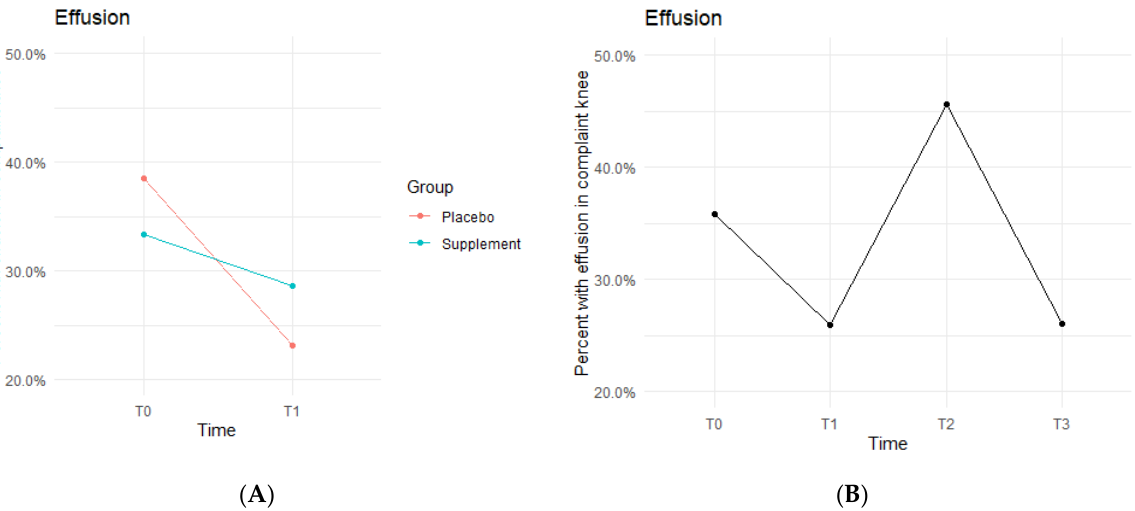
Figure 5. Effusion Changes Over Time. Average percentages of participants experiencing effusion were graphed on a plot. ( A ) compares Supplement vs. Placebo from T0 to T1. ( B ) shows averages for the entire cohort as a whole at times T0, T1, T2, and T3. Overall, the cohort started with 35.8% experiencing knee effusion, and dropped to 26% by the end of the study. Only affected knees were included in the data.